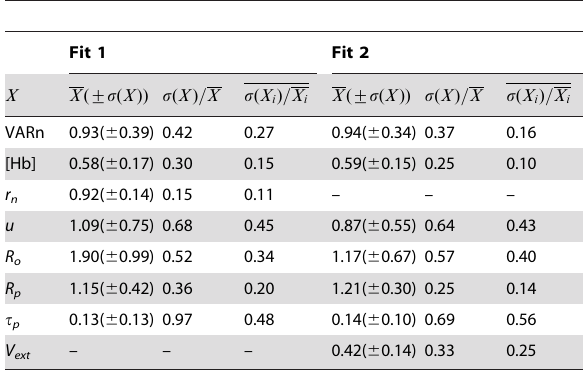
Table 6. Values of the free model parameters following optimisation.